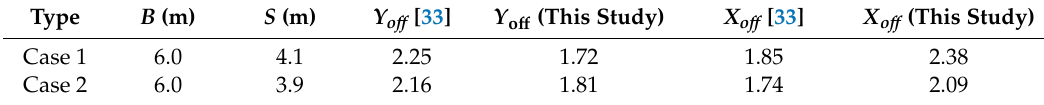
Table 4. Comparison between the present study (Case 1 and Case 2) and reference data for Equation (5).